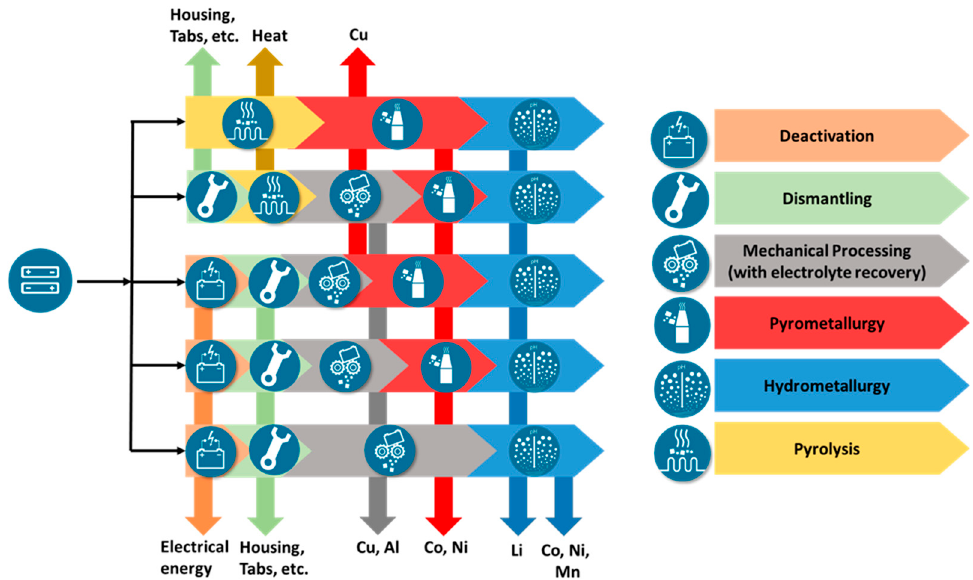
Figure 1. General overview of some potential recycling process chains in different combinations.